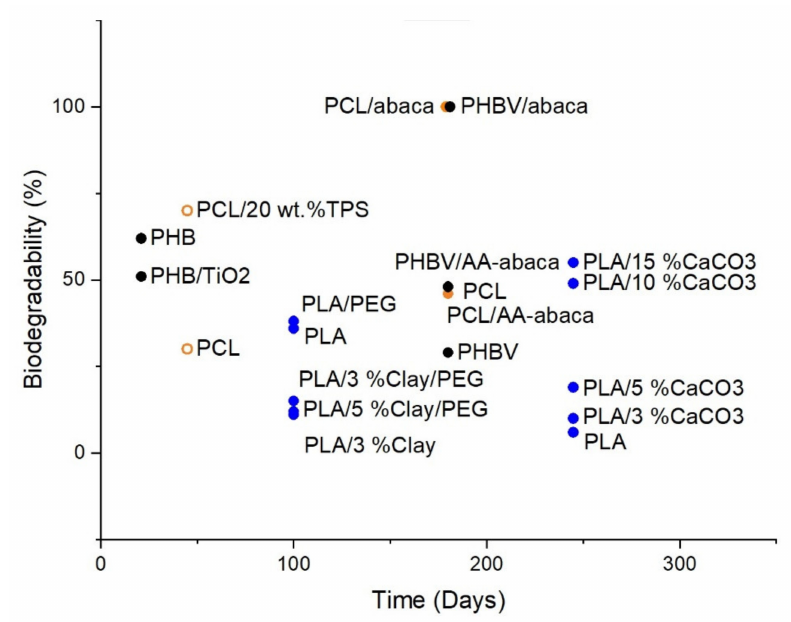
Figure 9. Biodegradability of PLA, PCL and PHB with the addition of various fillers and plasticisers in various soil burial degradation